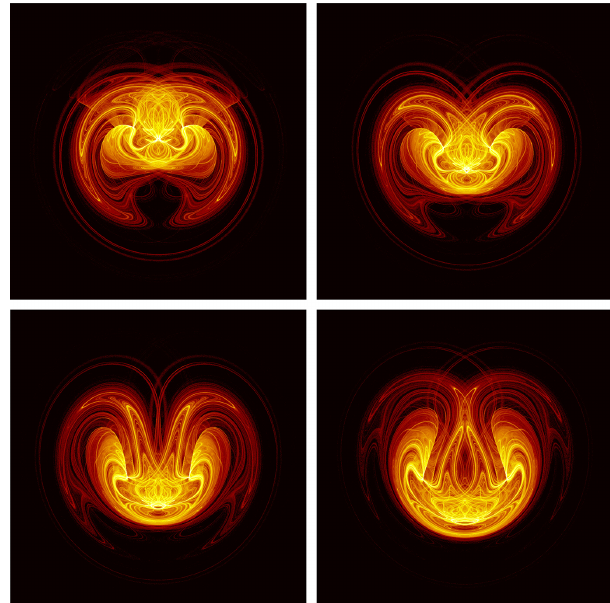
Figure 8. Heat maps of the time-dependent invariant measure ν t ( ω ) supported on four snapshots ( ω ) of LORA. The values of the pa- rameters r , s , and b are the classical ones, where the variance of the noise σ = 0 . 5. The color bar is on a log scale, and it quanti- fies the probability of landing in a particular region of phase space; a projection is shown of the 3-D phase space ( X,Y,Z ) onto the ( X,Z ) plane. Note the complex, interlaced filament structures be- tween highly populated regions (in yellow) and moderately popu- lated ones (in red). Reprinted from Physica D: Nonlinear Phenom- ena, 240, Chekroun et al. (2011), Stochastic climate dynamics: Ran- dom attractors and time-dependent invariant measures, 1685–1700, © 2011 Elsevier B.V. All rights reserved. 2011, with permission from